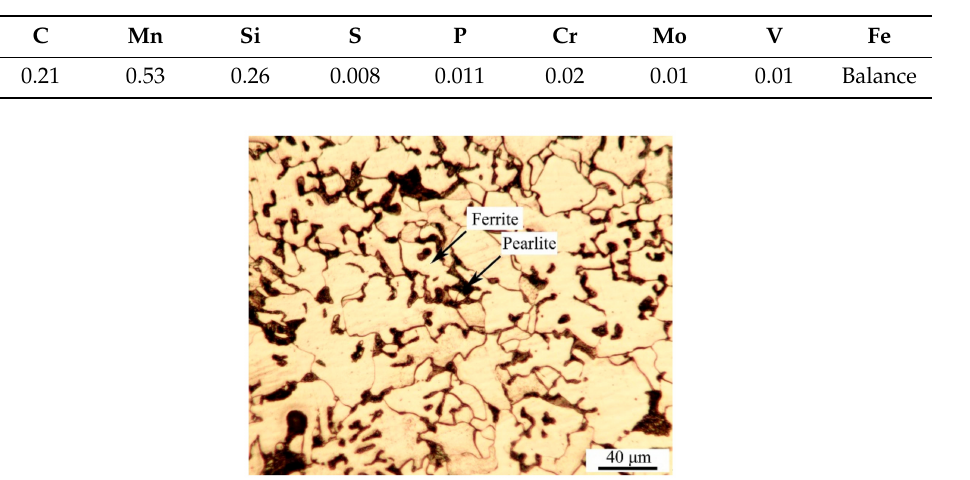
Table 1. Chemical composition of the SA106B carbon steel (wt. %).